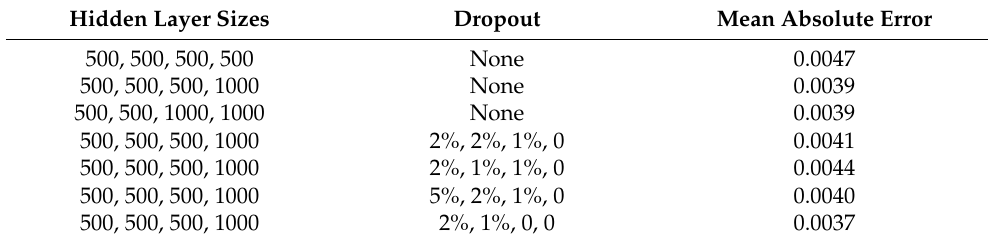
Table 2. A sample of trialled SNN model architectures and their associated accuracy metrics.